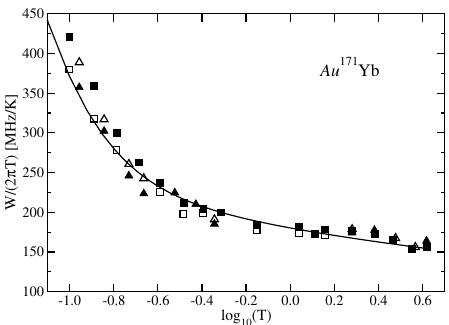
Figure 1. Relaxation rate over T of Au 171 Yb for 9 GHz (X-band) as a function of T . Open symbols denote the m I = + 1/2 transitions and closed symbols the m I = − 1/2 transitions. Triangles correspond to a sample with 280 ppm and squares to a sample with 670 ppm. The solid curve is Equation (19) for T K = 0.5 × 10 − 8 K. Adapted with permission from Ref. [3], American Physical Society, 2018. For | ω | , T , g f µ B B (cid:48) (cid:28) T K , on the other hand, a singlet spin state forms as a consequence of